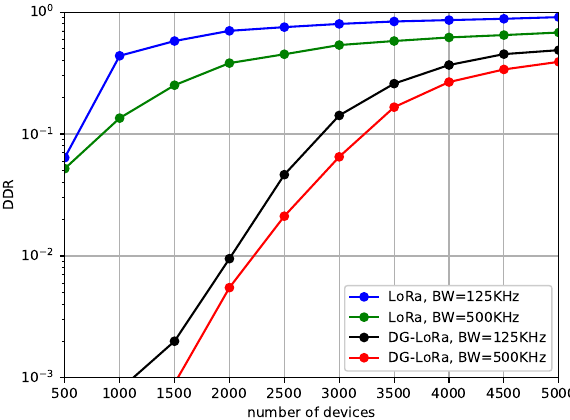
Figure 7. Data drop rate according to the channel bandwidth.